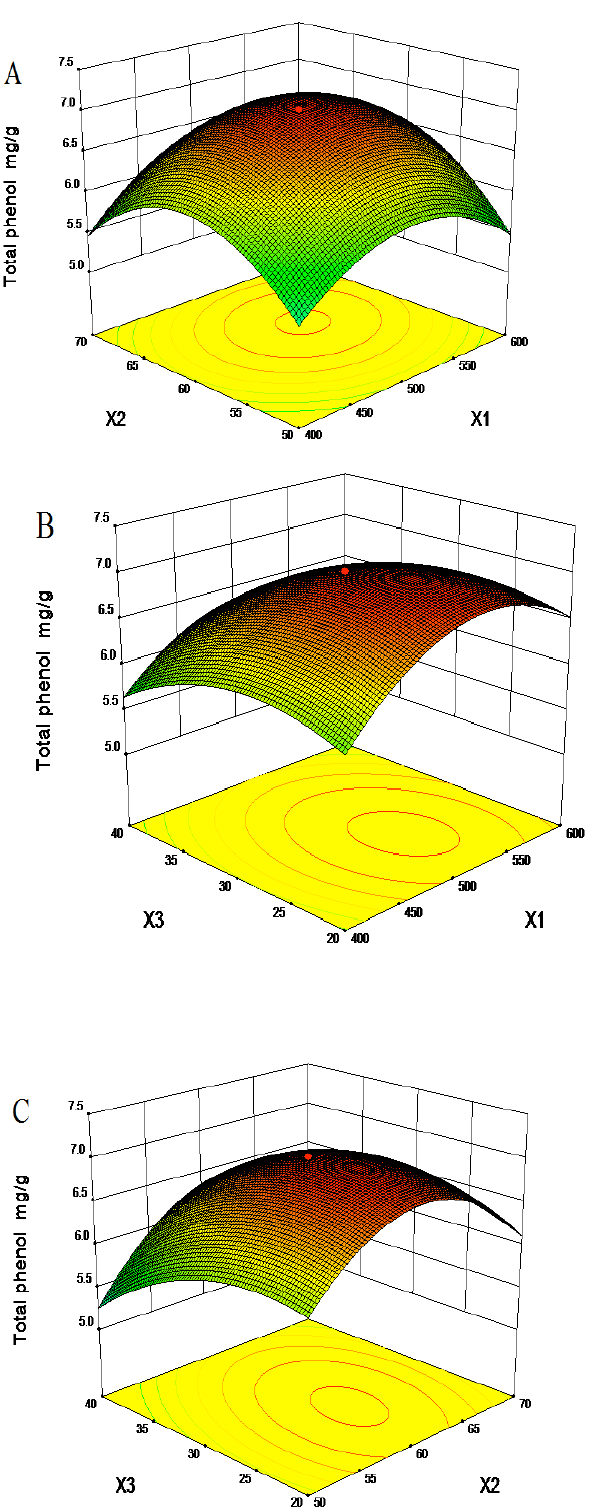
Fig. 1: Response surface for the effect of independent variables on poly- phenols extraction yield. (A) Response surface graph showing interaction between ultrasonic power (X 1 /W) and ethanol concentration (X 2 /%); (B) response sur- face graph showing interaction between ultrasonic power (X 1 /W) surface for the effect of independent variables on polyphenols extraction yield. 416 Fig.1: Response and solvent-to-material ratio (X 3 /mL/g); (C) response surface graph showing interaction between ethanol concentration (X 2 /%) and sol- vent-to-material ratio (X 3 /mL/g). (A) Response surface graph showing interaction between ultrasonic power (X